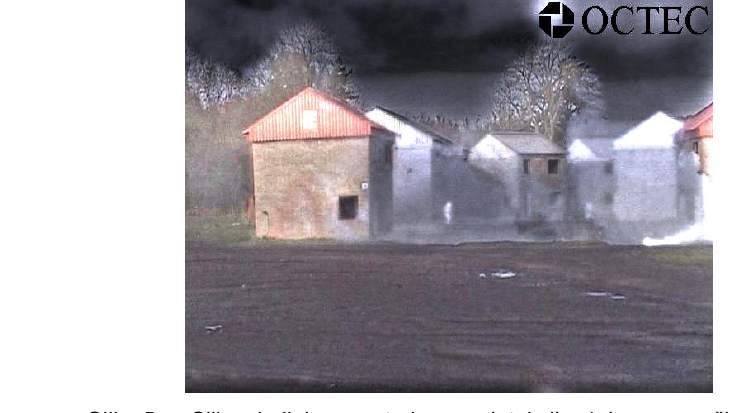
Figure 5 – Fused image with the method for Concealed Weapon